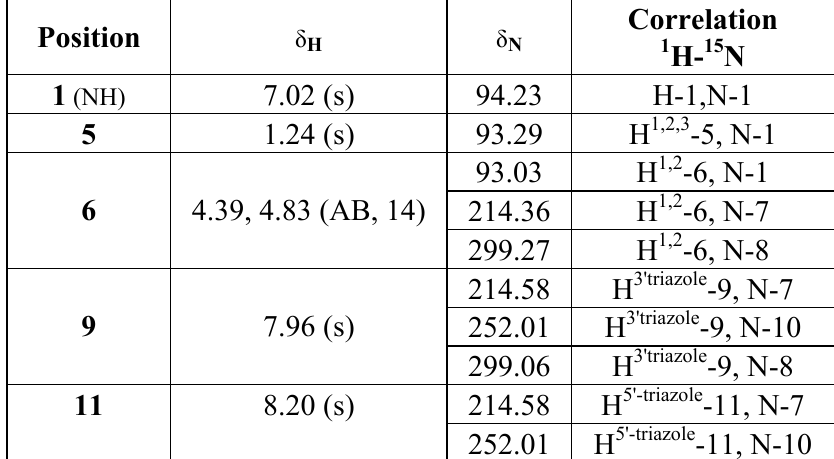
Table 2. Listing of 15 N (400 MHz) NMR spectral data for 4 in DMSO- d6 , including results obtained by heteronuclear single quantum coherence shift-correlated ( HSQC ) and heteronuclear multiple bond coherence shift-correlated ( HMBC ).